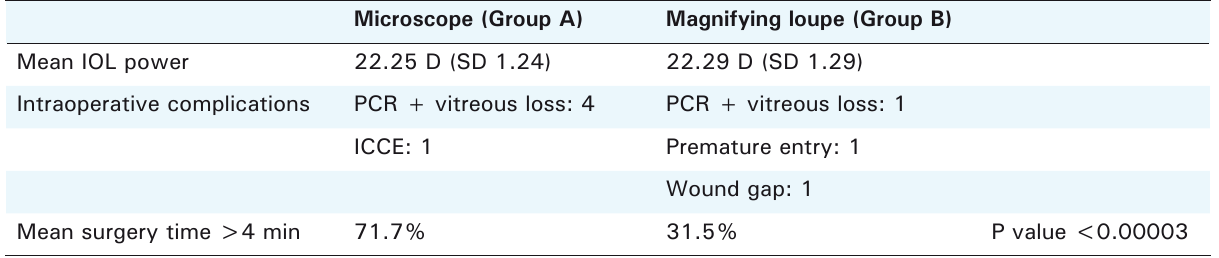
table 2. Intraoperative